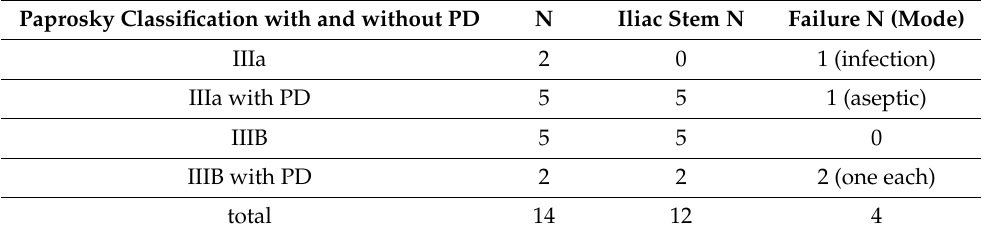
Table 1. Classification of acetabular defects with treatment strategy and failures (number = N; pelvic discontinuity =